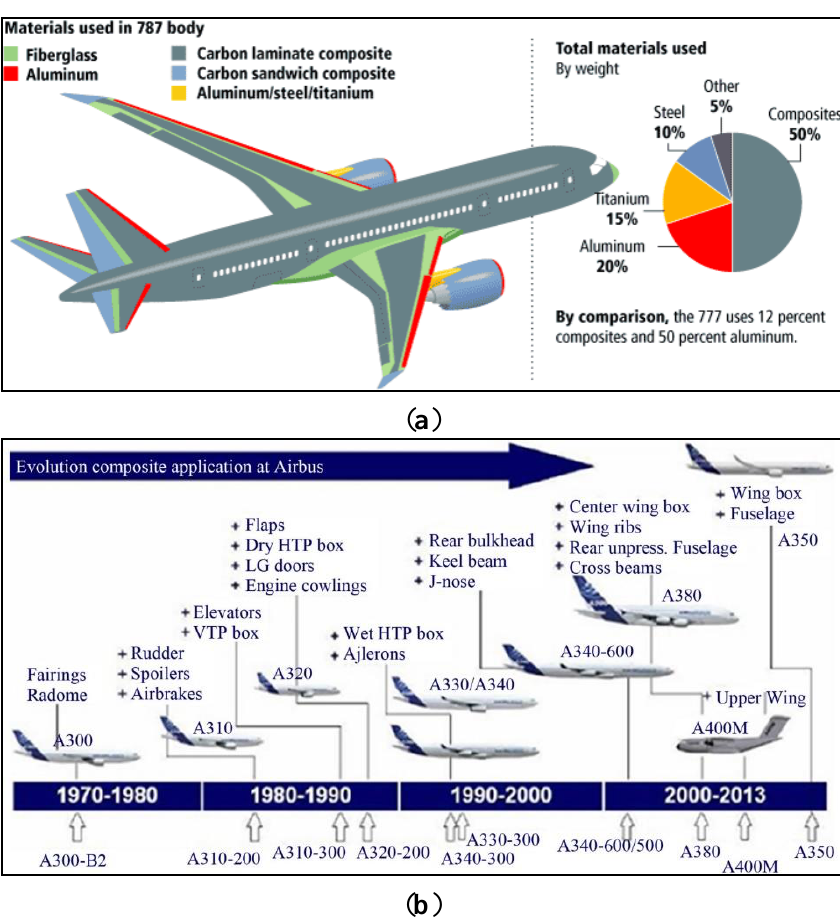
Figure 1. ( a ) Use of composite materials in the Boeing 787 and ( b ) evolution of the use of composites in Airbus